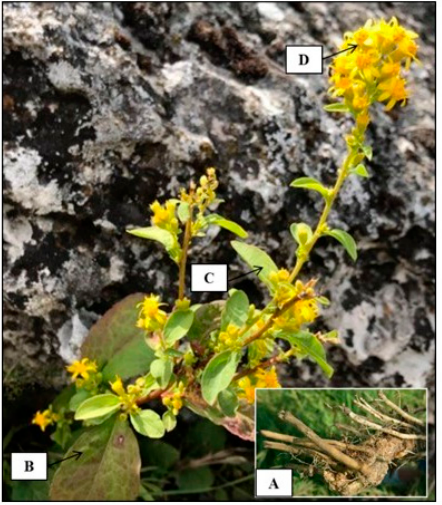
Figure 2. S. virgaurea (original photo): ( A ) oblique rhizome, ( B ) basal leaves, ( C ) cauline leaves, ( D ) radiate flower heads.